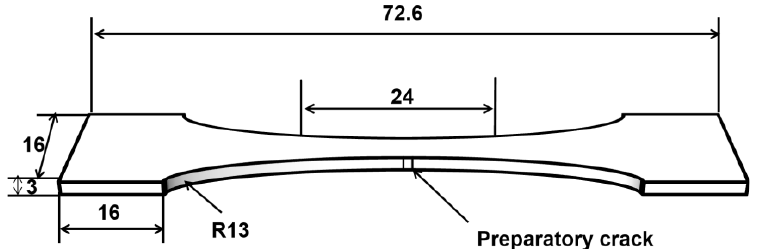
Figure 4. Dimensions of the tensile sample.